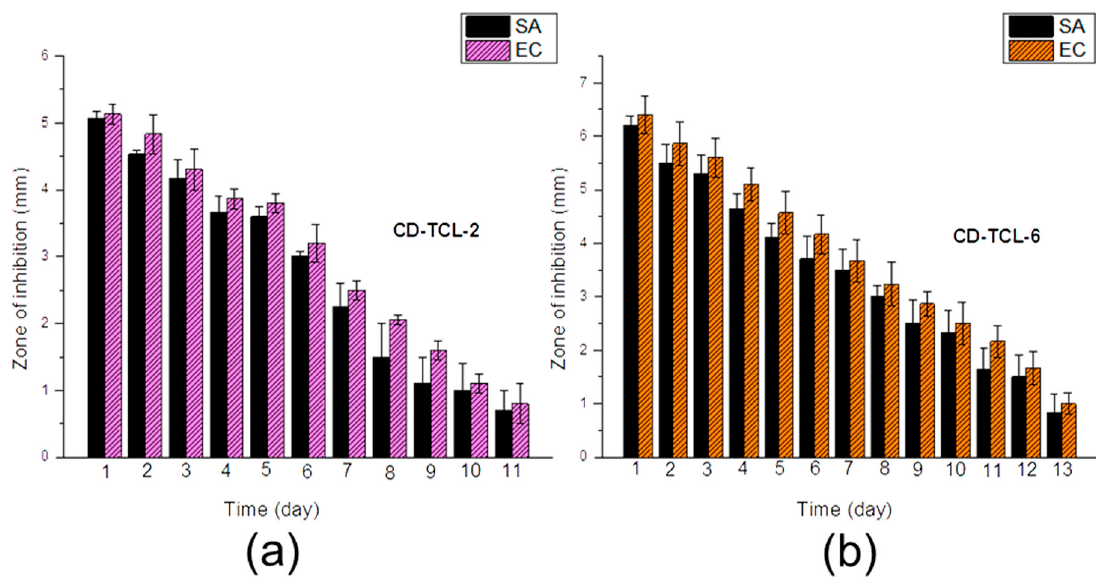
Figure 9. Sustained efficacy test ( a ) CD-TCL-2, ( b ) CD-TCL-6. Data for antimicrobial test samples are expressed as an average of three samples ( n = 3).